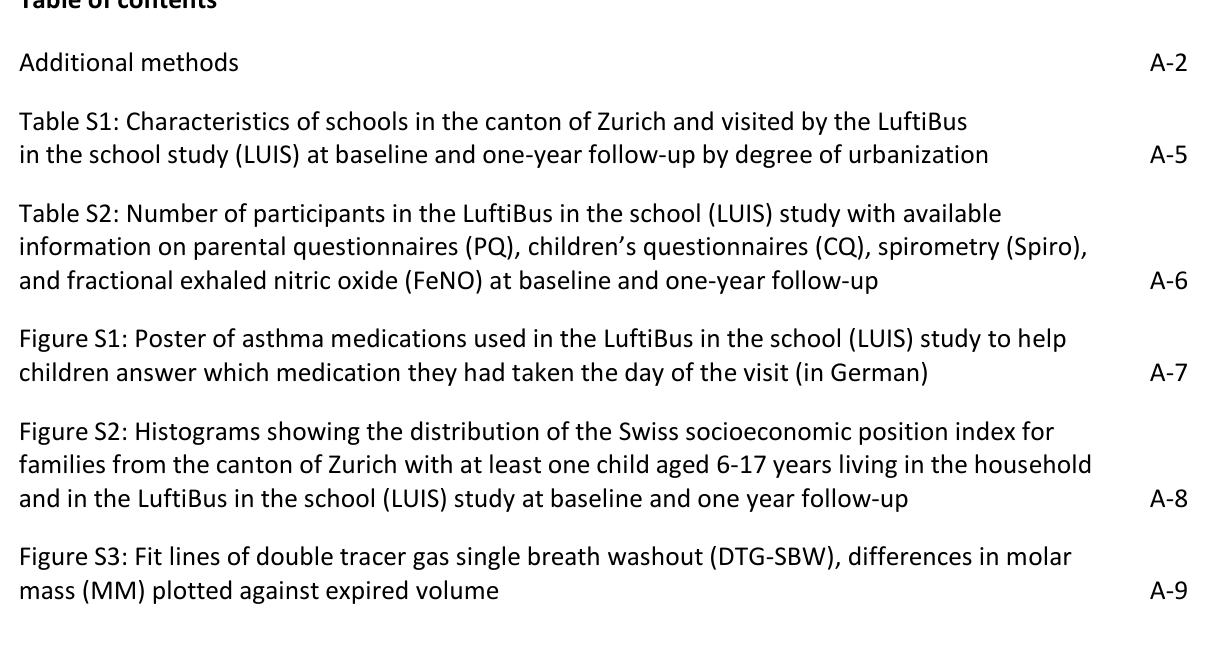
Table S1: Characteristics of schools in the canton of Zurich and visited by the LuftiBus in the school study (LUIS) at baseline and one-year follow-up by degree of urbanization Table S2: Number of participants in the LuftiBus in the school (LUIS) study with available information on parental questionnaires (PQ), children’s questionnaires (CQ), spirometry (Spiro), and fractional exhaled nitric oxide (FeNO) at baseline and one-year follow-up Figure S1: Poster of asthma medications used in the LuftiBus in the school (LUIS) study to help children answer which medication they had taken the day of the visit (in German) Figure S2: Histograms showing the distribution of the Swiss socioeconomic position index for families from the canton of Zurich with at least one child aged 6-17 years living in the household and in the LuftiBus in the school (LUIS) study at baseline and one year follow-up Figure S3: Fit lines of double tracer gas single breath washout (DTG-SBW), differences in molar mass (MM) plotted against expired